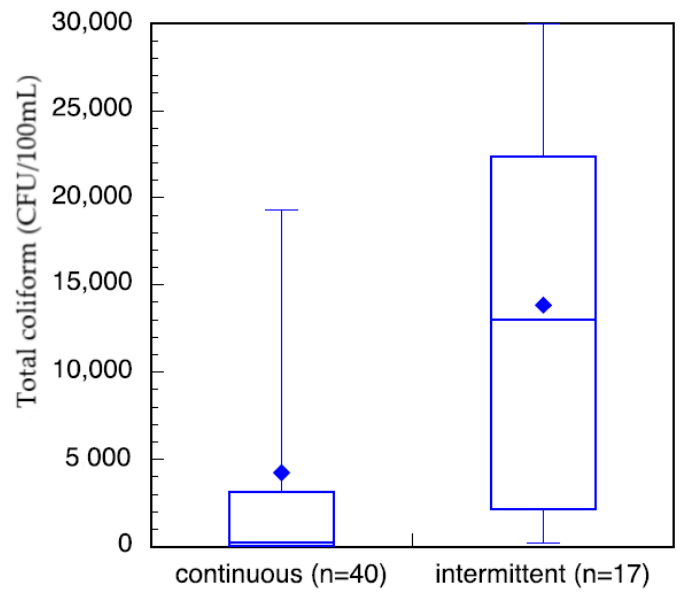
7 Figure 7. Box-and-whisker plot of total coliform measurements of stored water in the wet season in study households in communities that had verified continuous access to municipal treated water versus verified intermittent